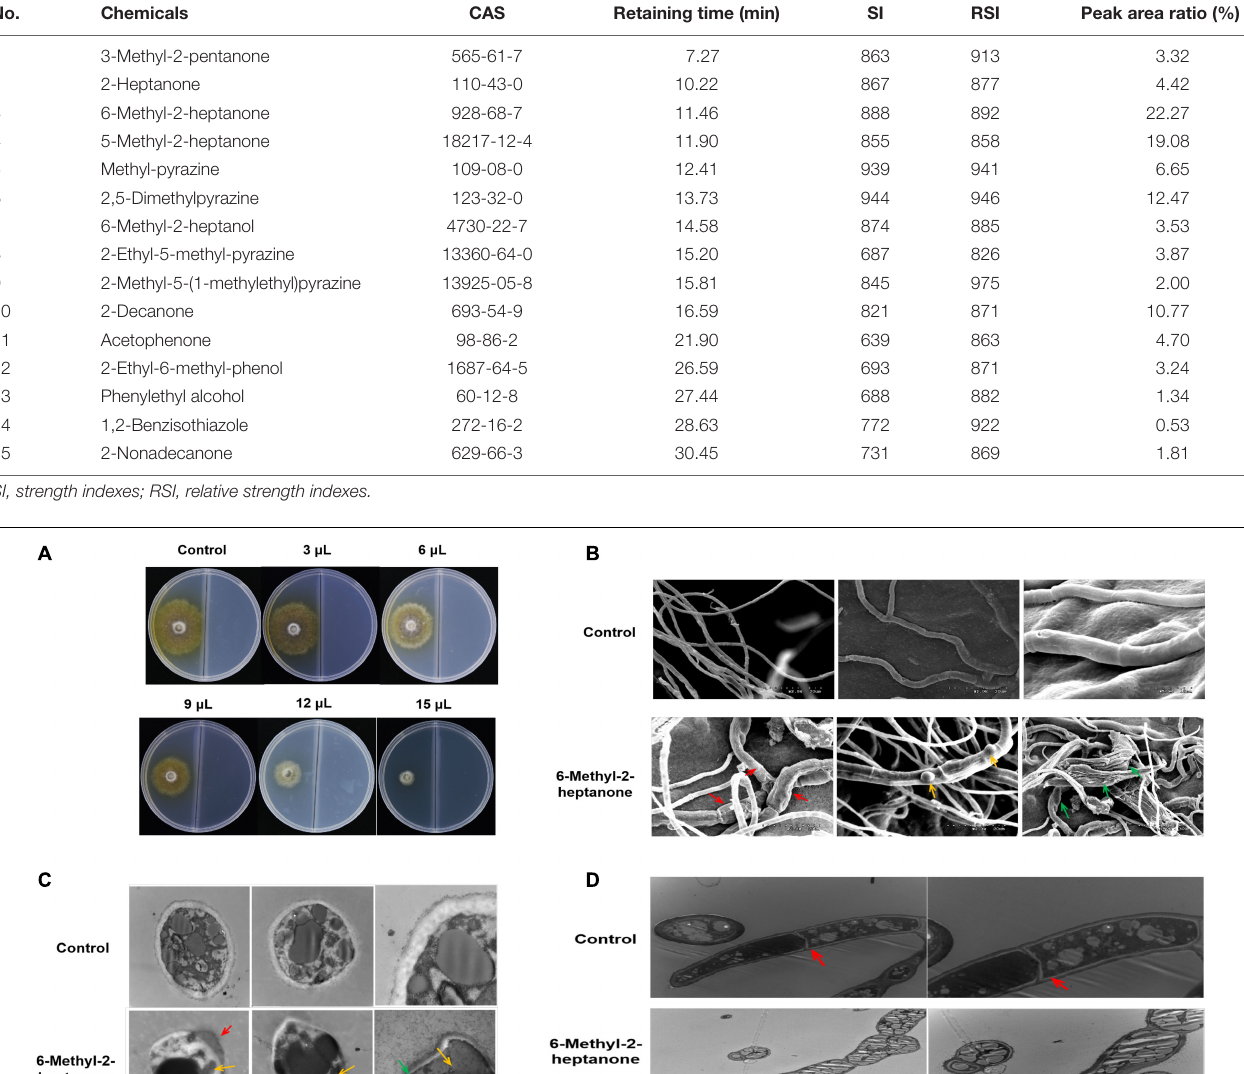
density. Nuclei, vacuoles, and mitochondria were also distributed randomly in the cells ( Figure 2C ). Compared with the undamaged control cells, a wide range of misshapen and severely deformed cells were observed in treated A . solani . Cell walls